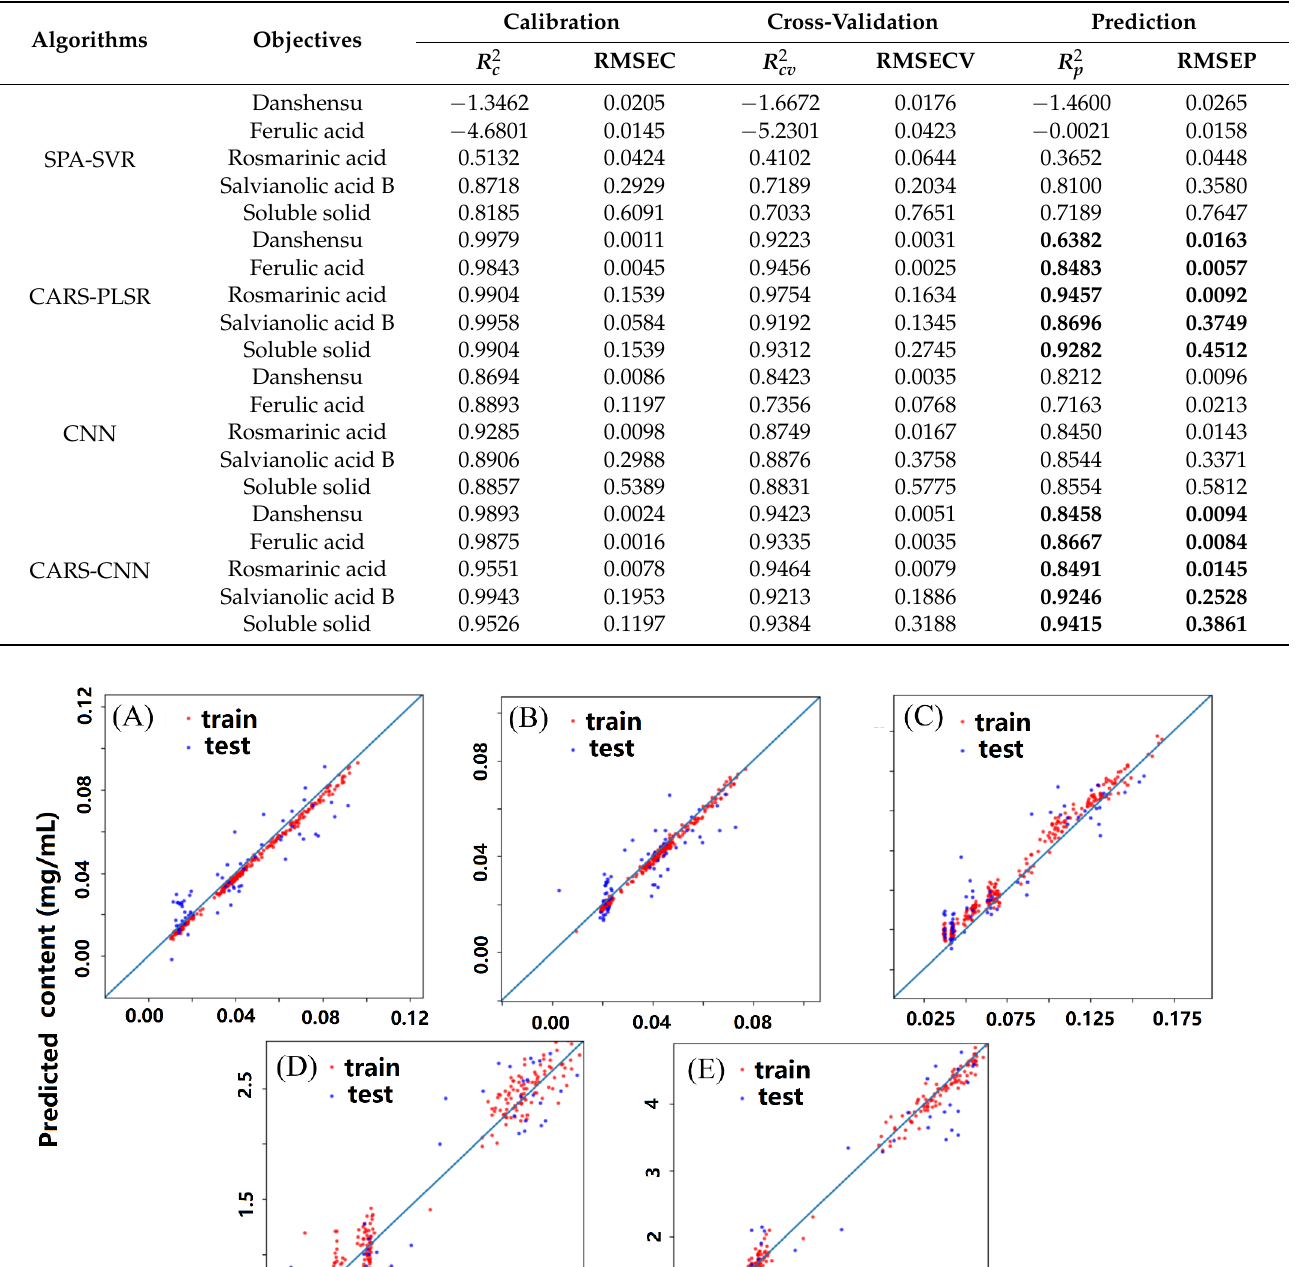
Table 1. Comparisons between performance parameters of four quantitative calibration models established with different regression algorithms.